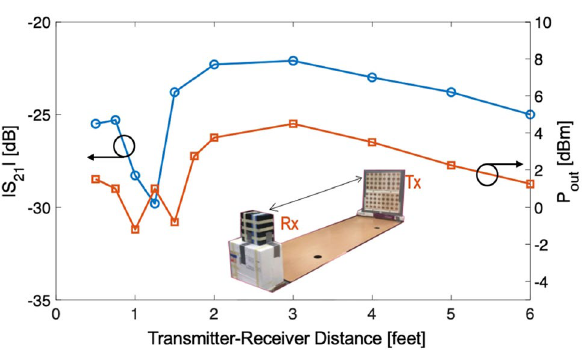
Figure 4. Transmission capabilities of the developed transmitter using a single element receiver as a function of distance between the Tx and Rx. Plot generated using Matlab R2019b available at https:// mathw orks.